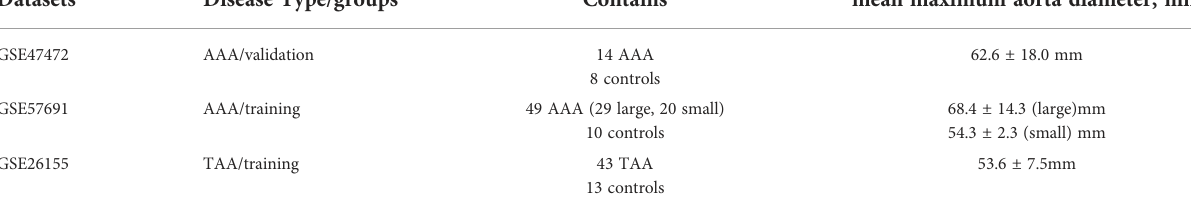
TABLE 1 Characteristics of the three AA